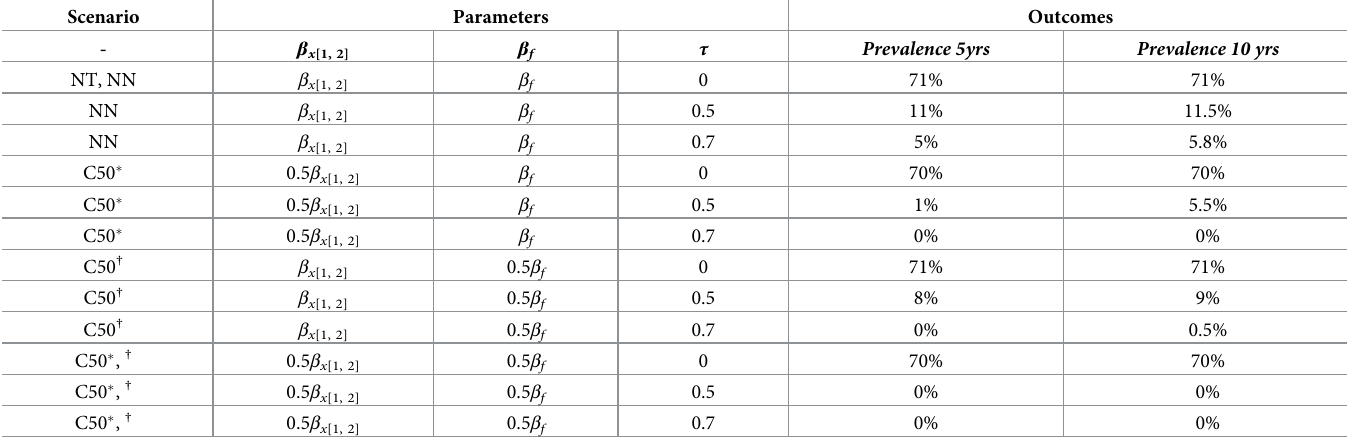
Table 2. Approximate prevalence after 5 and 10 years, with different combinations of treatment and neutering. NT: no treatment, NN: no neutering or other contact reduction measures, C50: 50% neutering. Treatment levels are specified by parameters τ . � effect on sexual contacts, † effect on fighting. Scenario Parameters Outcomes Prevalence 5yrs Prevalence 10